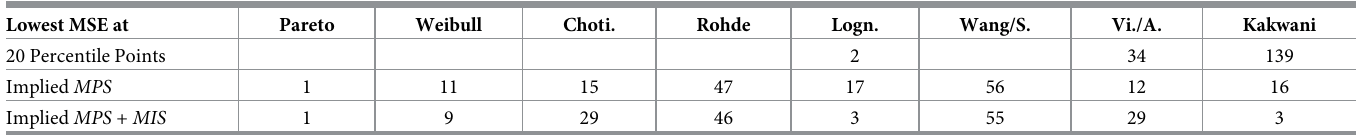
Table 7. Performance of functional